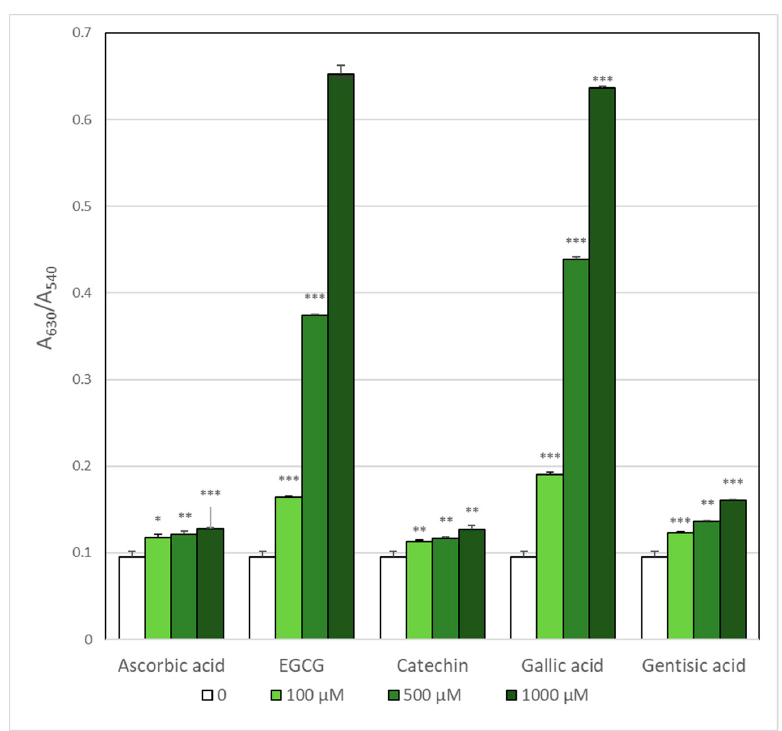
Figure 5. Oxidation of hemoglobin by selected antioxidants in the absence of AAPH. * p < 0.05, ** p < 0.01, *** p < 0.001 with respect to control.